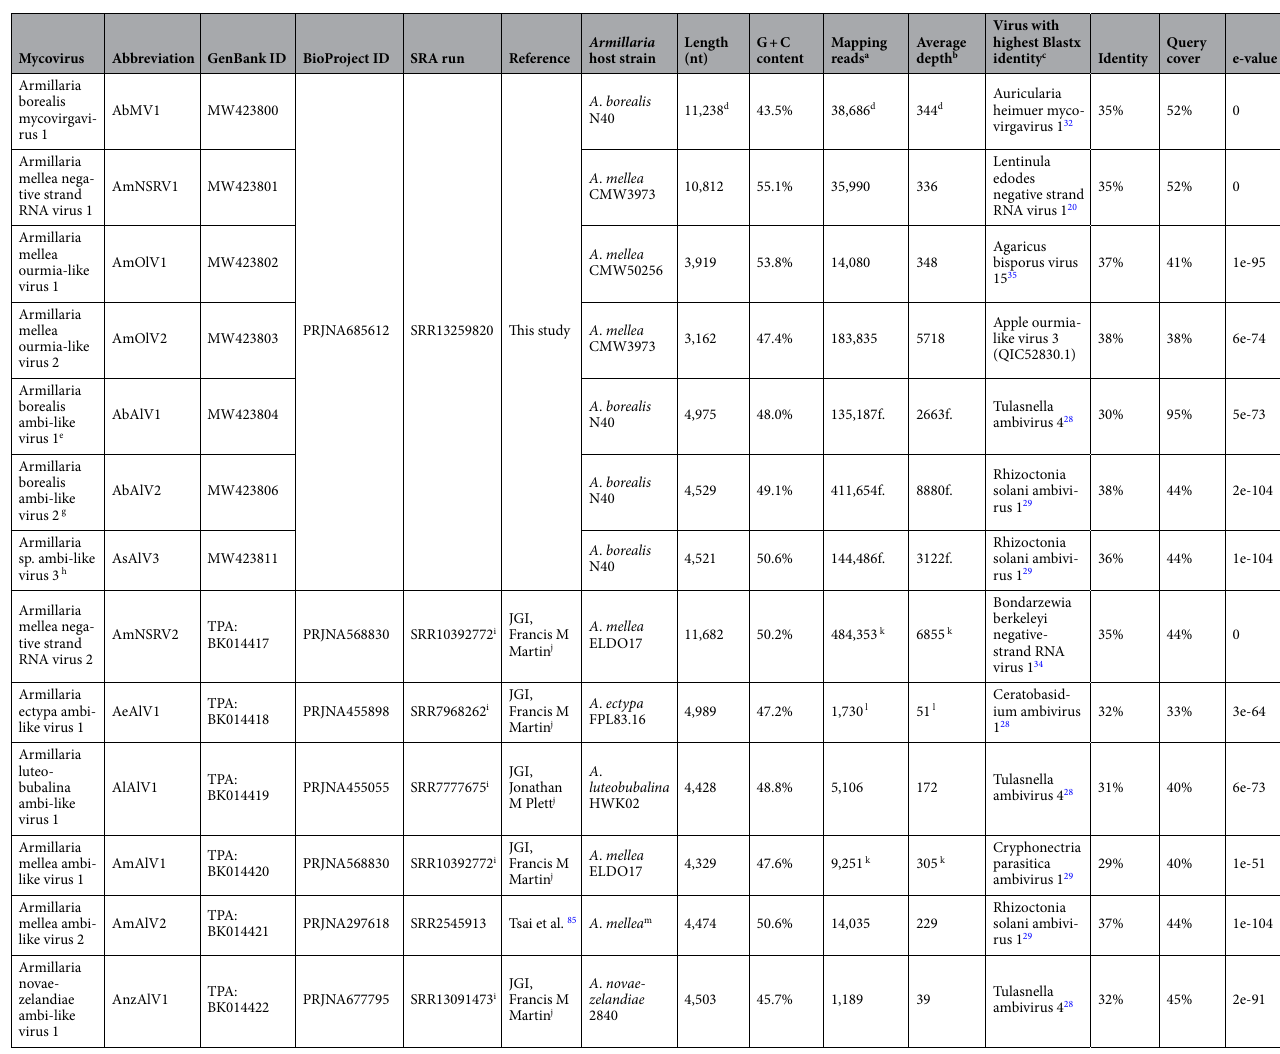
Table 1. Mycoviruses detected in our collection of Armillaria isolates or in transcriptomics datasets deposited in the NCBI SRA database. a Raw reads were mapped against the virus sequence using Geneious for RNA